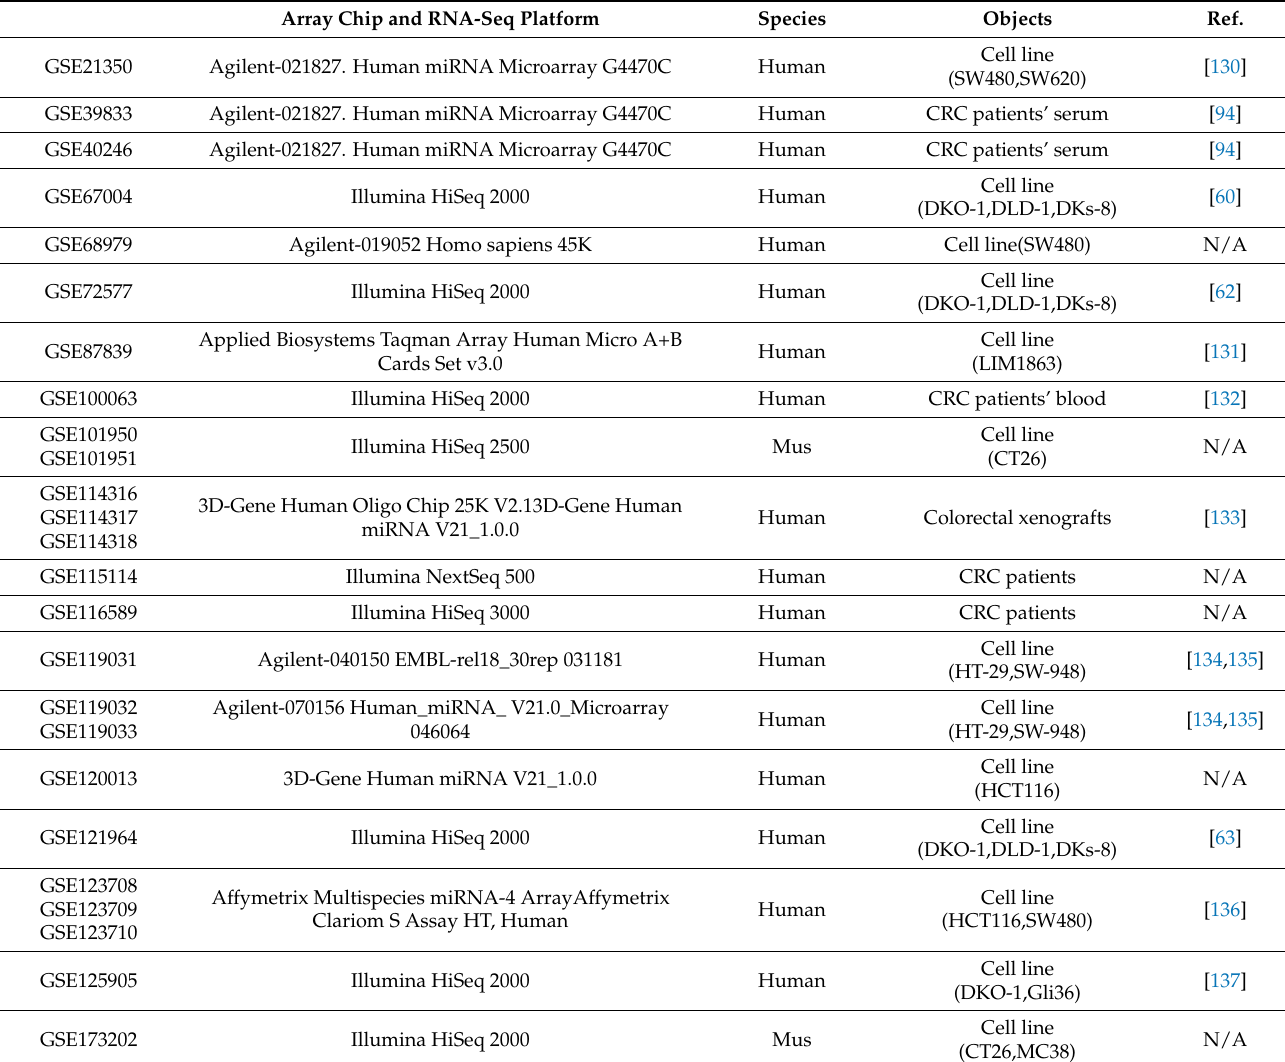
Table 3. Available microarray chips and RNA-seq datasets of exosomal research in colorectal cancer from the GEO website. Array Chip and RNA-Seq Platform Species Objects